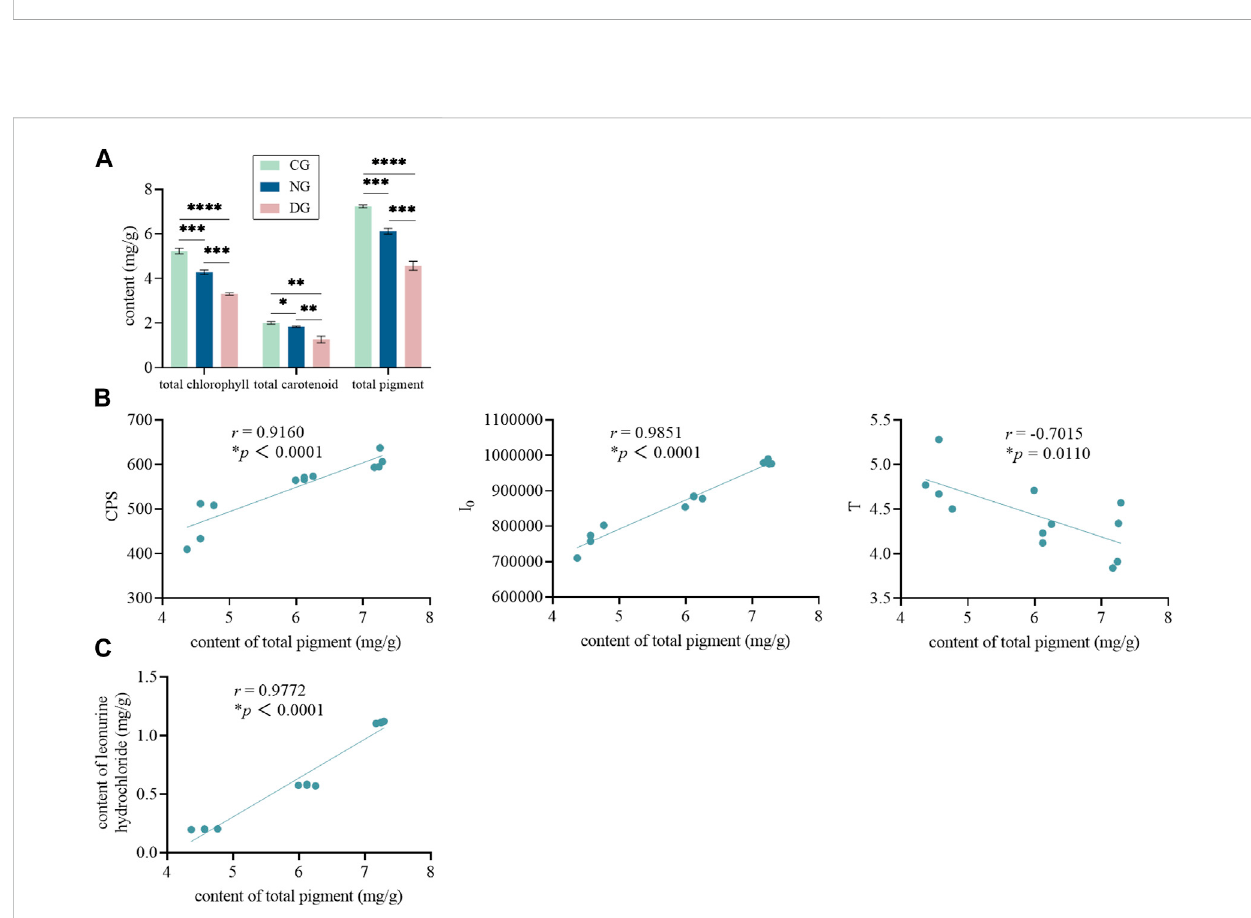
The pigment content and correlation analysis of motherwortleaves indifferent groups. (A) The t-testof thepigment contentin different groups. (B) The correlation analysis between the pigment content and the biophoton parameters. (C) The correlation analysis between the content of pigment and leonurine